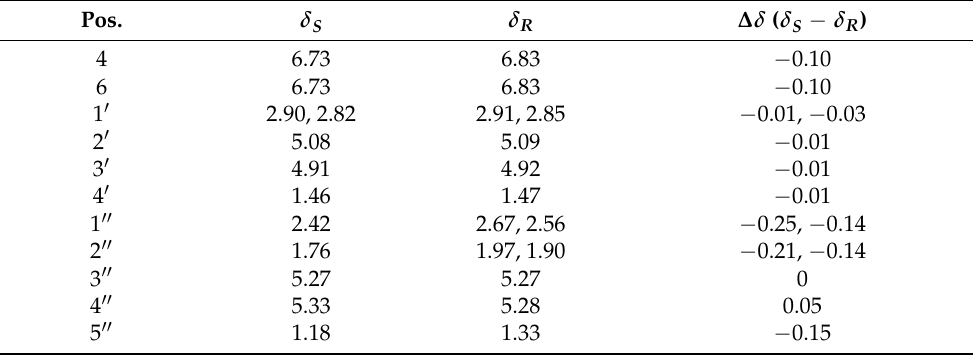
Table 2. 1 H-NMR spectroscopic data of ( S )- and ( R )- esters derivatives of compound 2